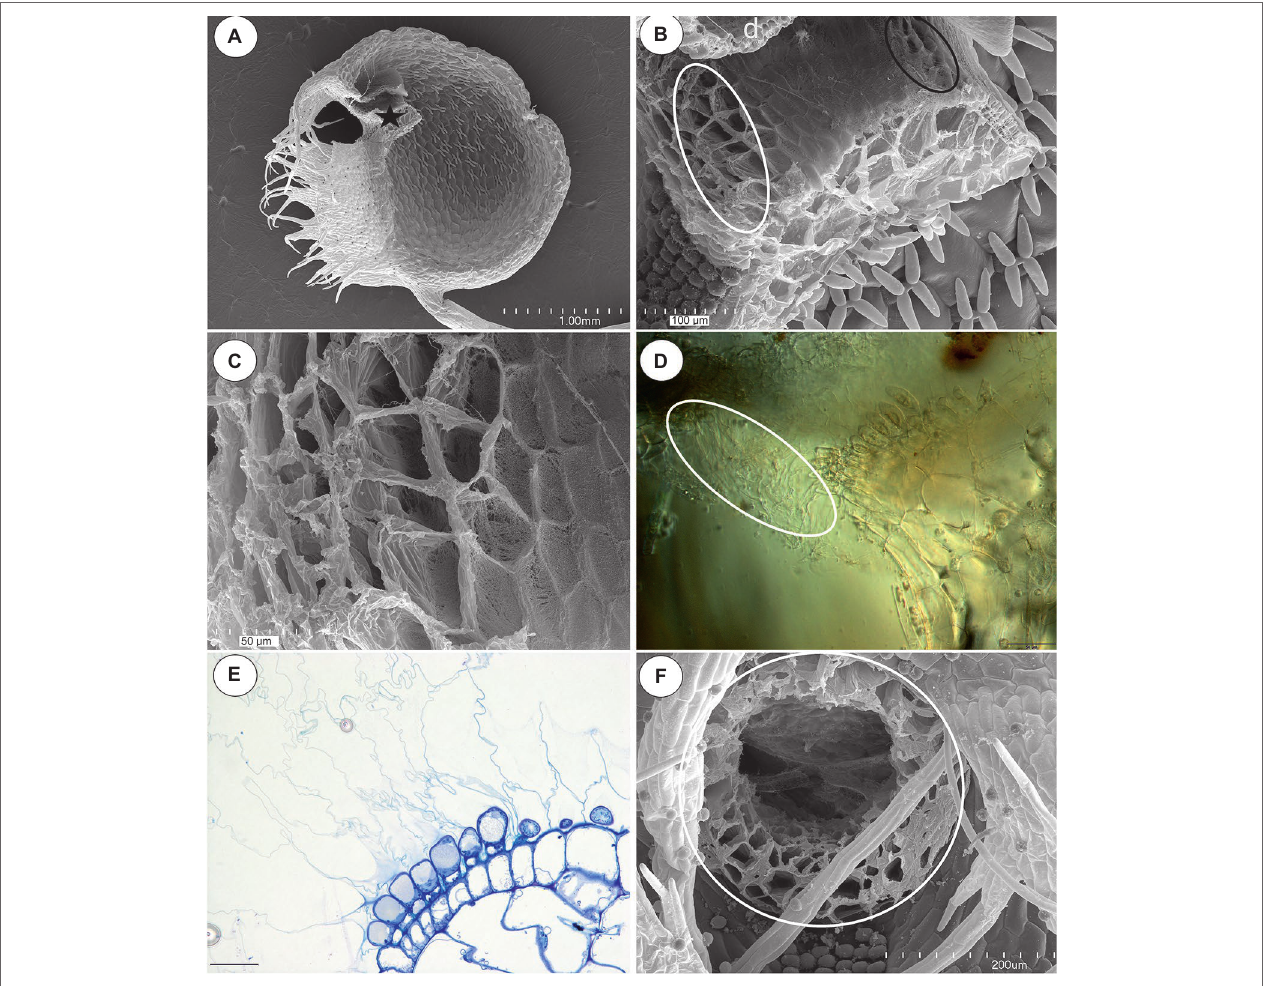
FIGURE 1 | The general structure of the trap and velum of Utricularia novae-zelandiae . (A) SEM image of a longitudinal section of an Utricularia novae-zelandiae trap: the threshold with the pavement epithelium (star), door (d); scale bar = 1 mm. (B) A longitudinal section of a Utricularia novae-zelandiae trap entrance, note the outer velum (white ellipse, this part is zoomed in Figure 2C ) and inner velum (black ellipse); scale bar = 100 μ m. (C) The outer velum, note the honeycomb-like structure of the velum; scale bar = 50 μ m. (D) Differential interference contrast microscopy; Utricularia novae-zelandiae trap entrance, note the outer velum (white eclipse); scale bar = 50 μ m. (E) A semi-thin longitudinal section of the threshold of the external part showing the trichomes that produce the external velum; scale bar = 20 μ m. (F) View of a trap entrance showing the ring of the velum (white circle); scale bar = 200 μ